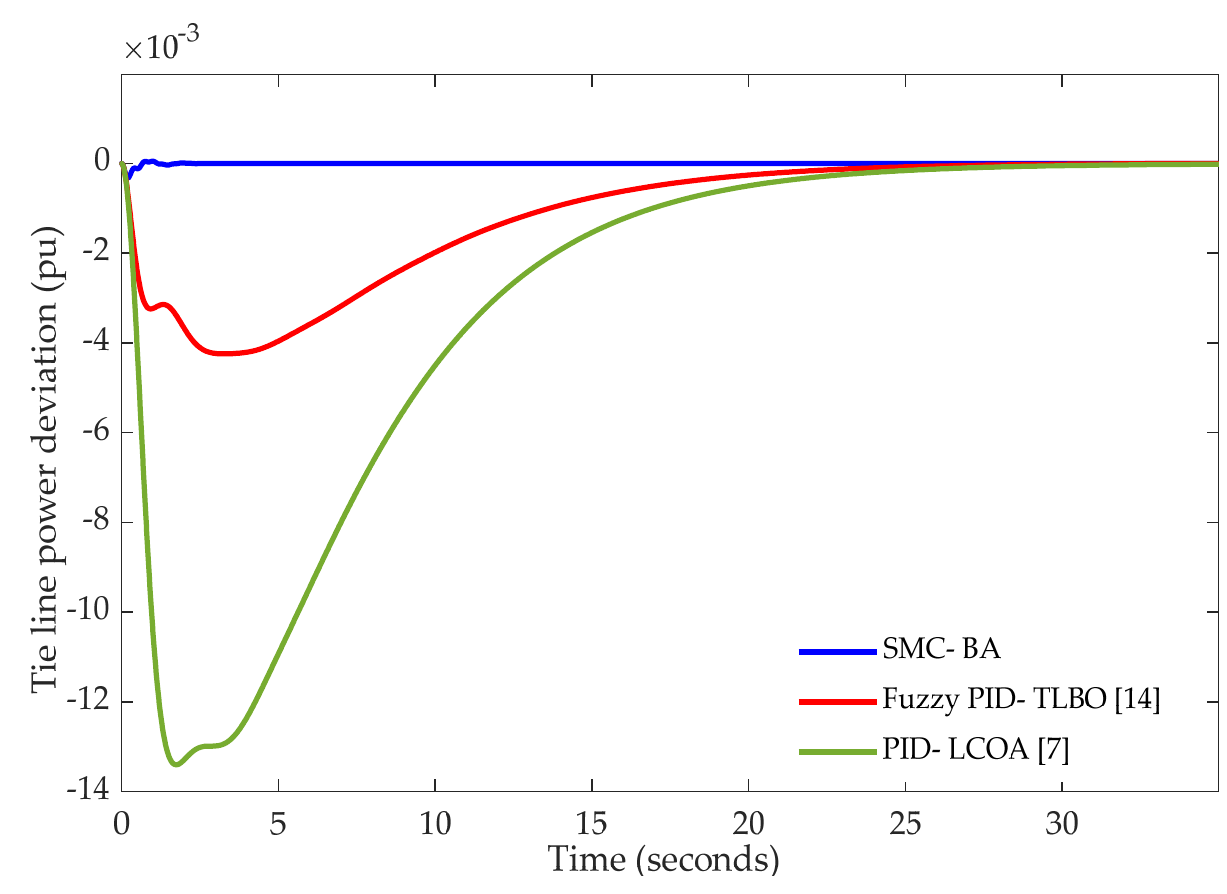
Figure 5. Tie line power deviation ( ∆ P tie in